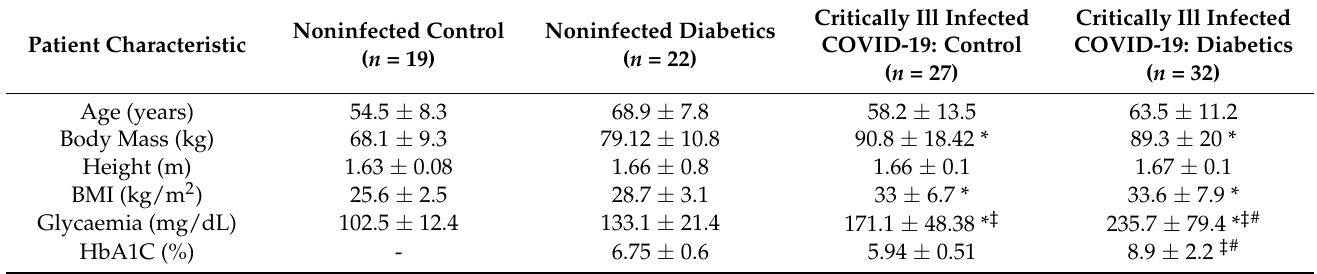
Table 2. Subjects’ characteristics and general biochemistry: All groups.